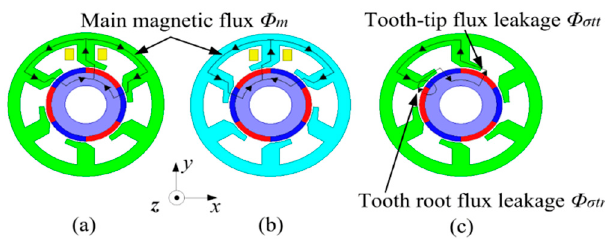
Figure 3. Magnetic flux paths of machine [16]. ( a ) Main magnetic flux path 1 of stator core; ( b ) Main magnetic flux path 2 of stator core; ( c ) Transverse-flux leakage path.